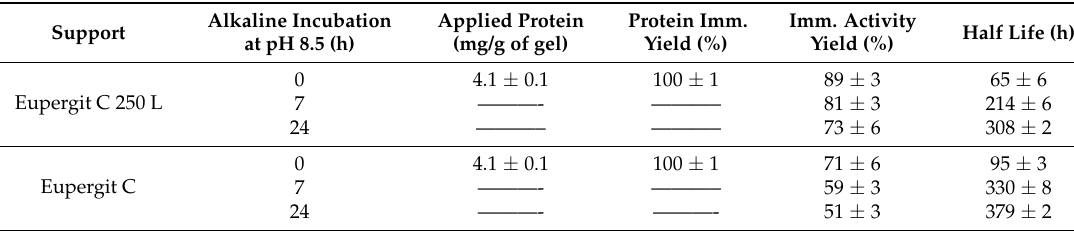
Table 1. Immobilization and stabilization of L -arabinose isomerase onto Eupergit C 250 L and Eupergit C 1 .